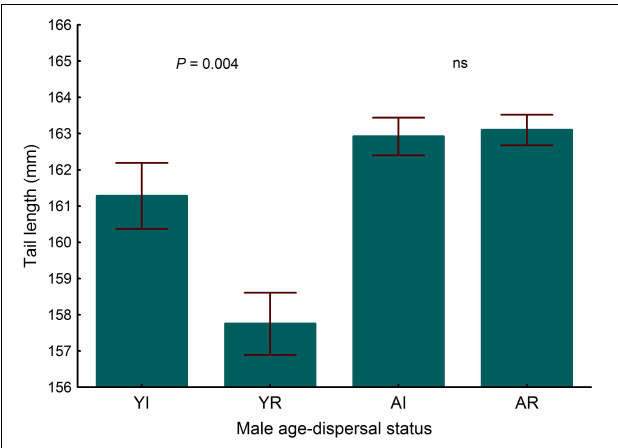
FIGURE 7 | Differences in tail length of breeding common kestrel males. YI is young immigrant, YR is young resident, AI is adult immigrant and AR is adult resident. P -values correspond to post-hoc comparisons between groups from the interaction between dispersal status and age in the LMMs. Values to the left and to the right correspond to differences in young and adults, respectively. “ns” means not significant differences ( P > 0.05). LMMs: young, estimate ± s.e . = 3.532 ± 1.21, t = 2.93. Bars and whiskers represent mean and s.e. values, respectively.